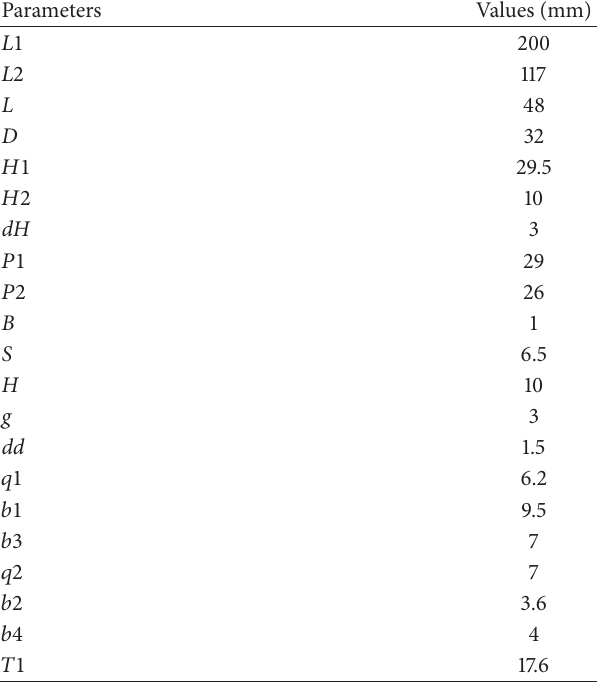
Table 1: Dimensions of the proposed